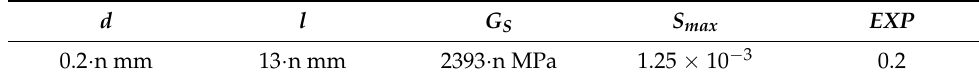
Table 2. Critical CBIS algorithm parameters under different n .